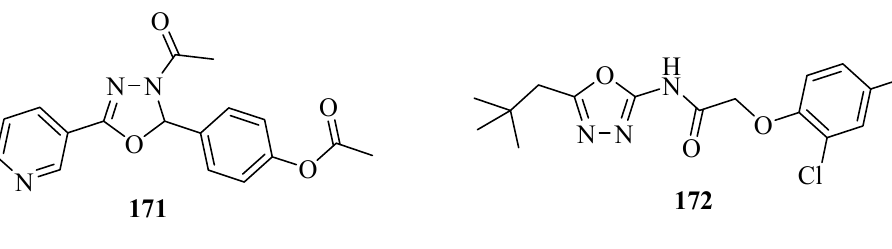
Figure 14. Vasorelaxant activity of